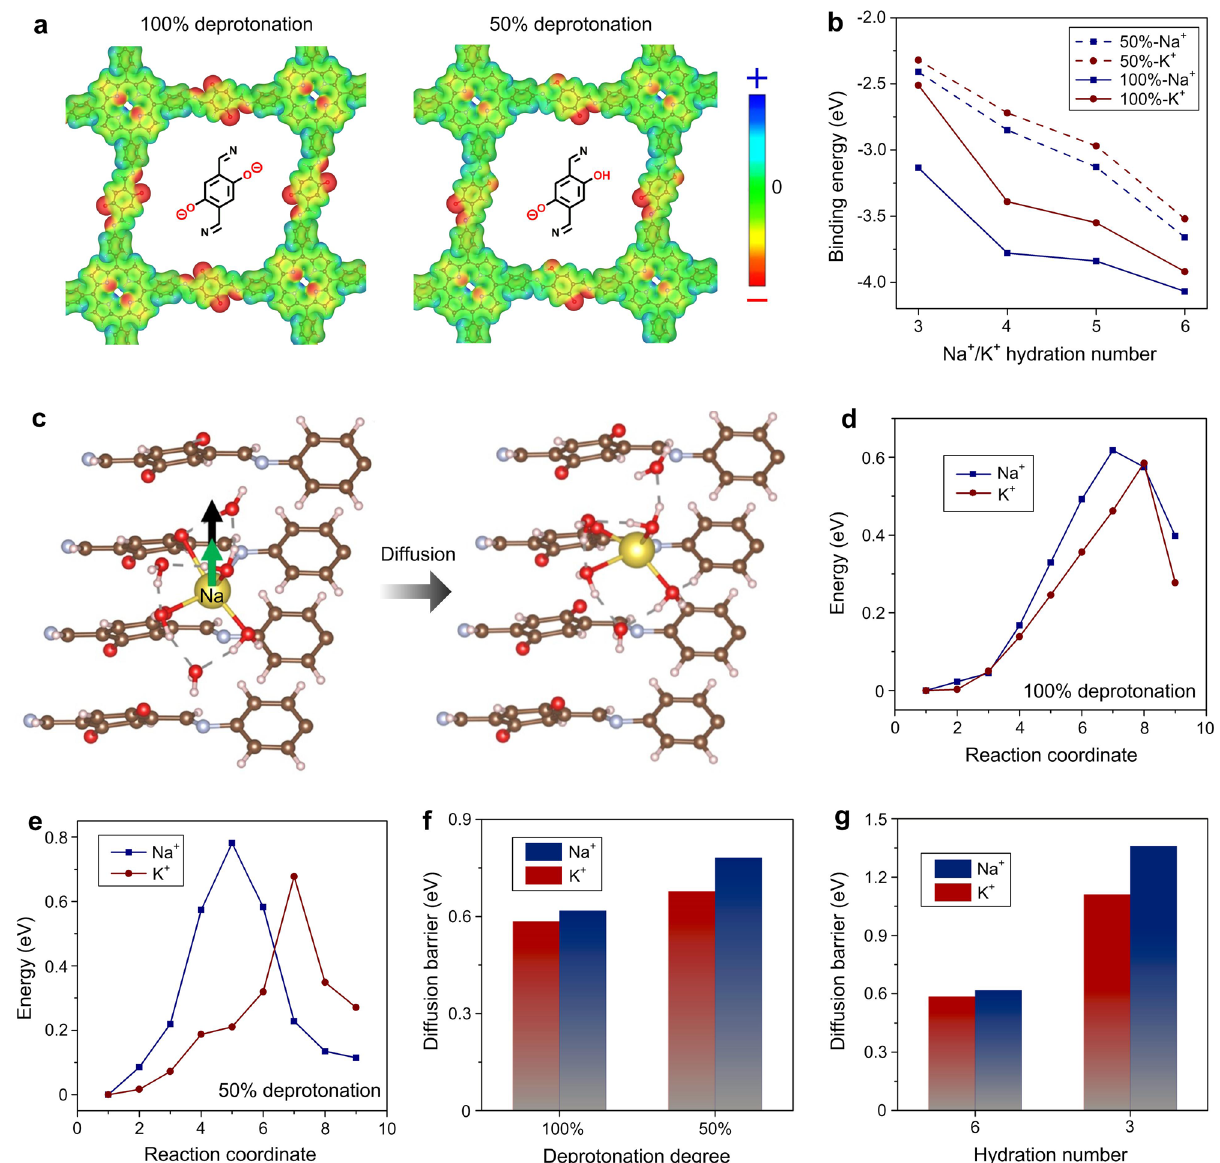
Fig. 4 Ion diffusion mechanism revealed by DFT calculations. a Electrostatic potential (ESP) surface (isosurface value: 0.01 e.Å − 3 ) of fully (100%) deprotonated and partially (50%) deprotonated 2DPI. The blue and red colors denote less and more electron density in the ESP surface, respectively. For the fully deprotonated 2DPI, electrons are strongly localized on oxygen anions followed by imine nitrogen, while the electrons are more concentrated on the deprotonated oxygen in the partially deprotonated 2DPI. b Binding energy of K + and Na + ions with different hydration numbers on fully and